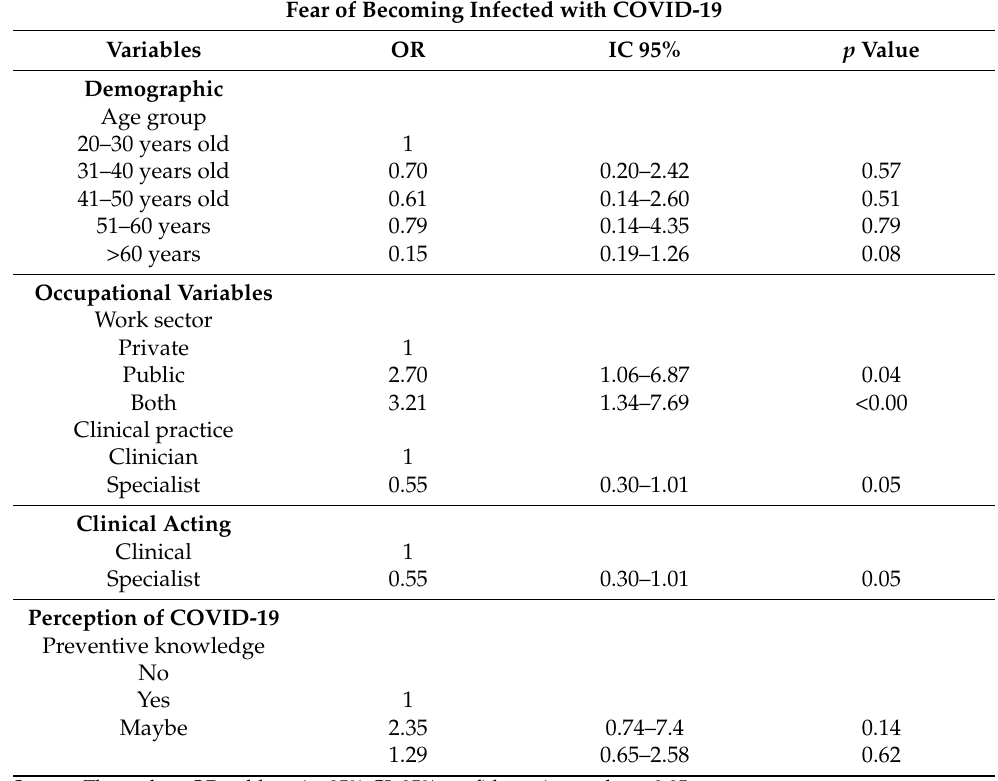
Table 4. Adjusted multivariate logistic regression between factors associated with fear of becoming infected. Fear of Becoming Infected with